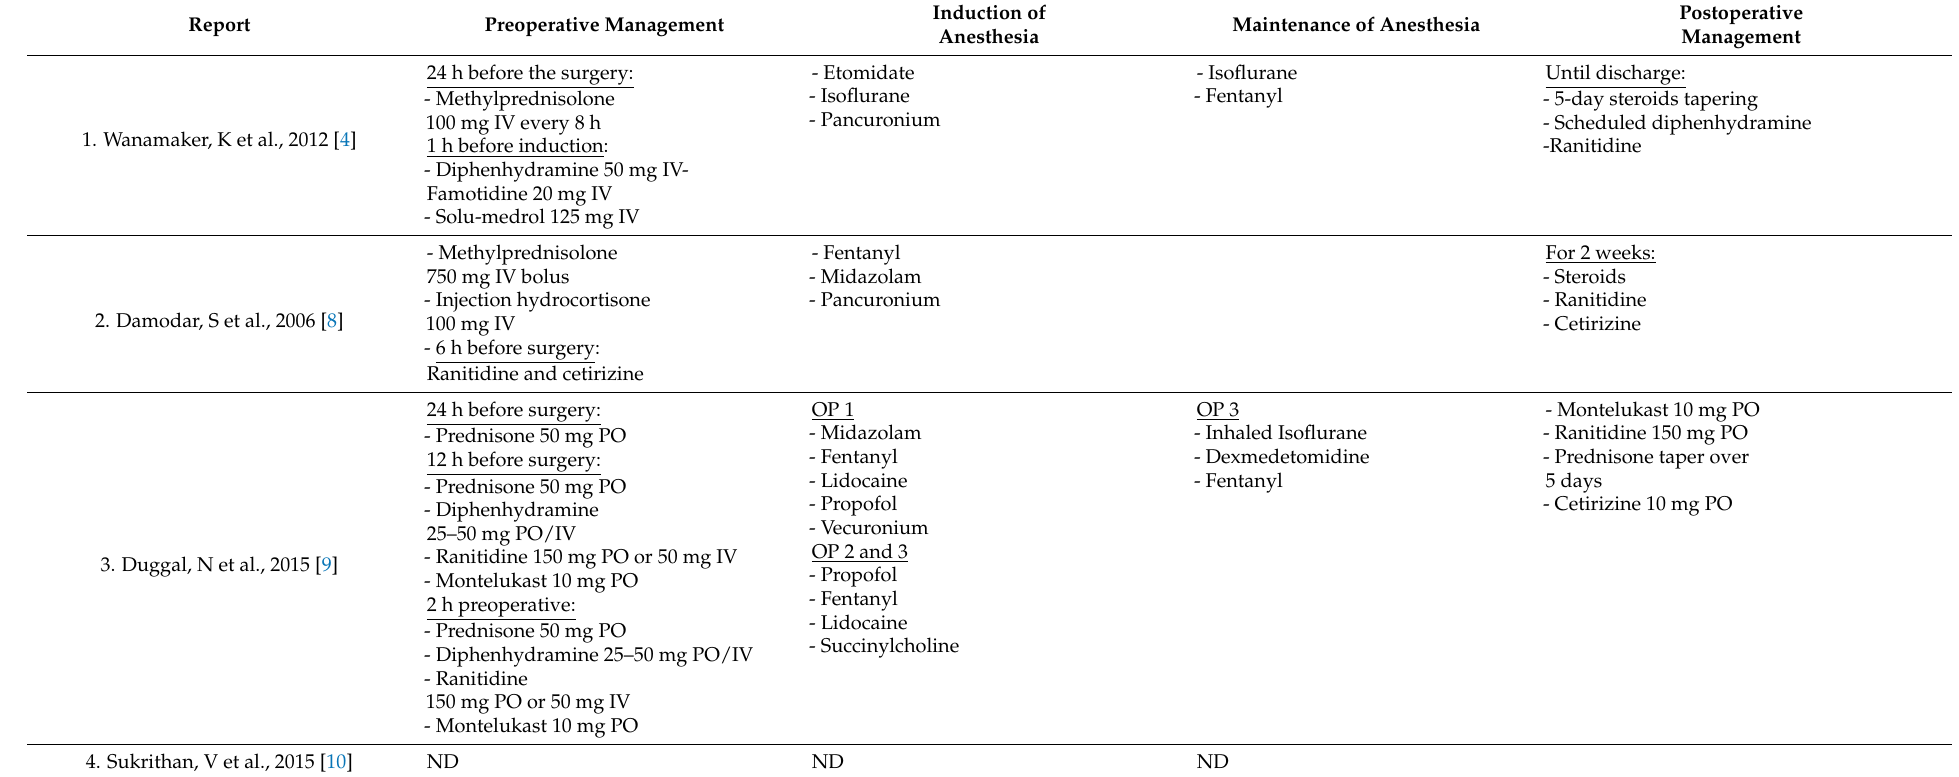
Table 2. Different anesthesia protocols, pre- and postoperative therapies used to control